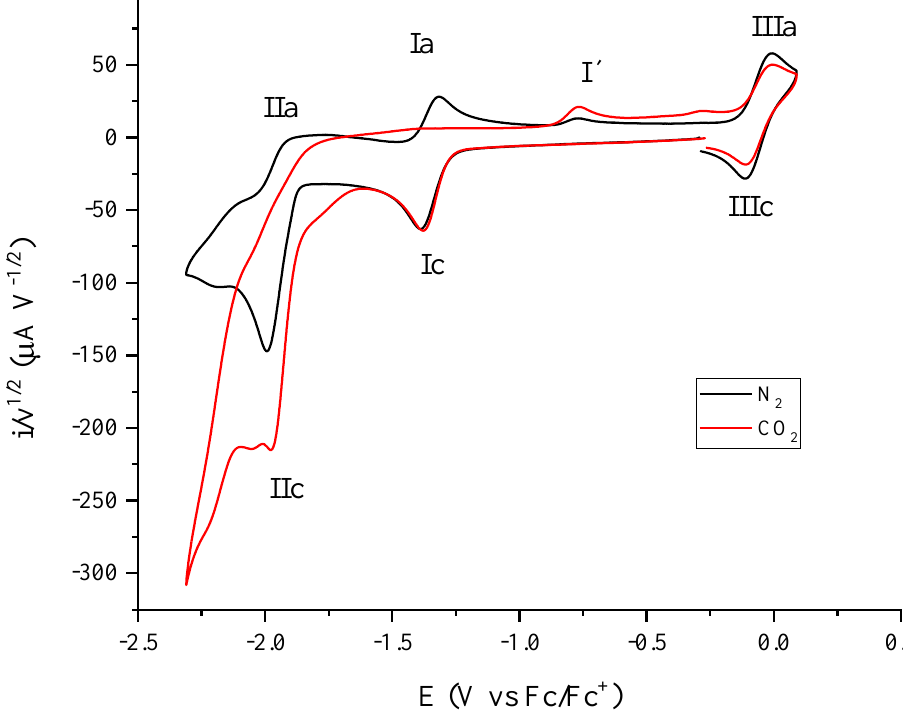
Figure 1. Cyclic voltammetry of a 1 mM [Co II (bipy) 3 ](BF 4 ) 2 solution in MeCN with 0.1 M of TBAPF 6 , bubbled with N 2 (black line) and CO 2 (red line). Scan rate of 100 mVs − 1 obtained from open-circuit potential to cathodic direction. Glassy carbon disk as a working electrode.